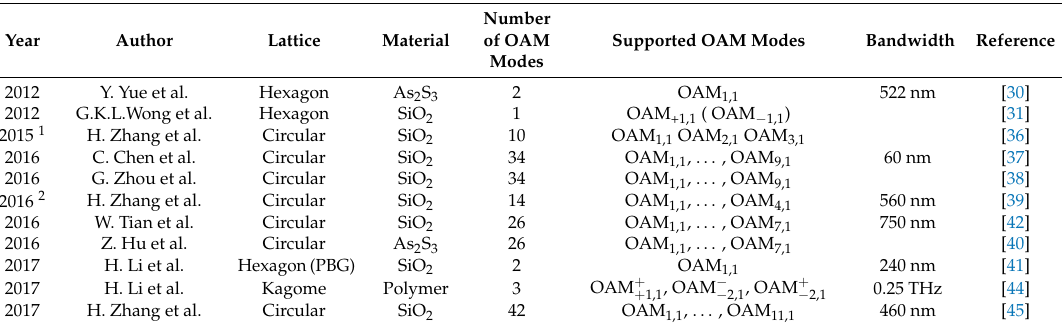
Table 2. OAM fibers based on PCF